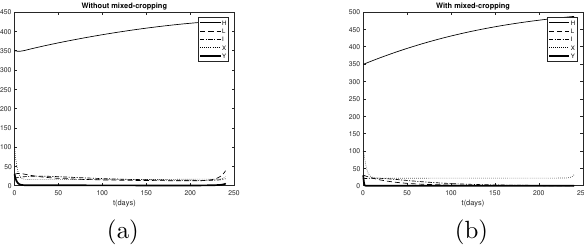
Figure 6. Simulations of the model (4.1) (a) without mixed-cropping, i.e. Q = 0 ,a 1 = a 2 = 1, and (b) with mixed-cropping system for Q = 200. The graphs show the disease can persist in the host population in case (a) but dies out in case (b).